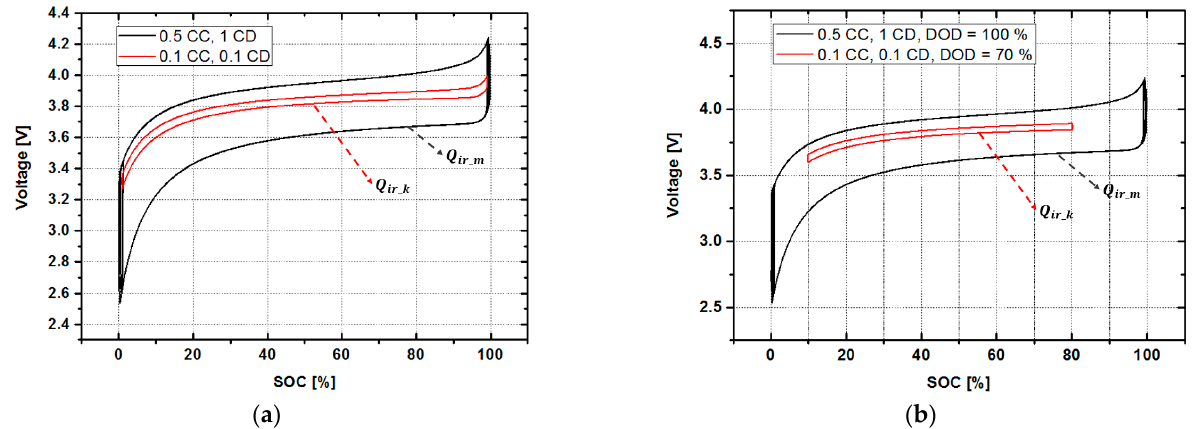
Figure 4. Change in the heat energy (Q) value according to the situation: ( a ) when only the charge/discharge currents are different and ( b ) when the charge/discharge currents are different and discharge of depth (DOD) is different.